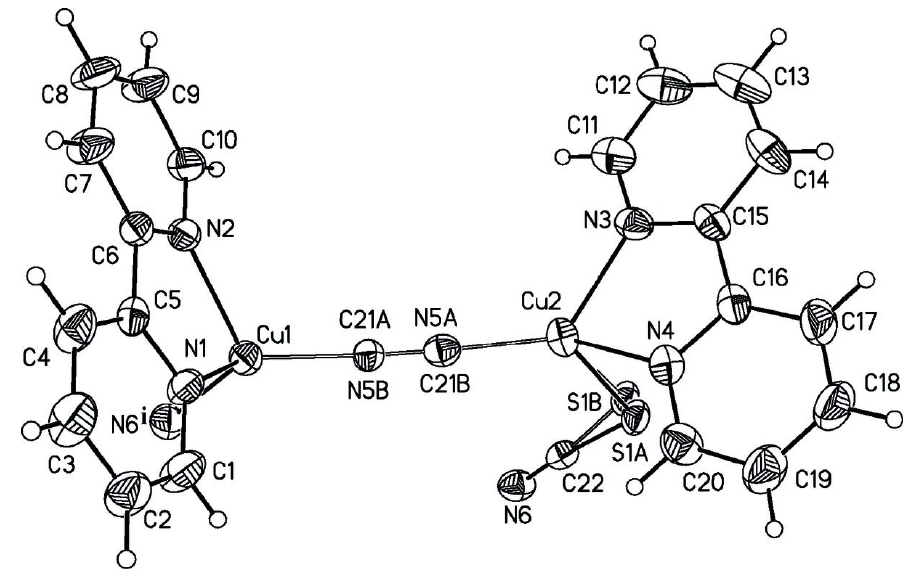
Figure 1 Part of the polymeric structure of the title compound. Displacement ellipsoids are drawn at the 30% probability level.